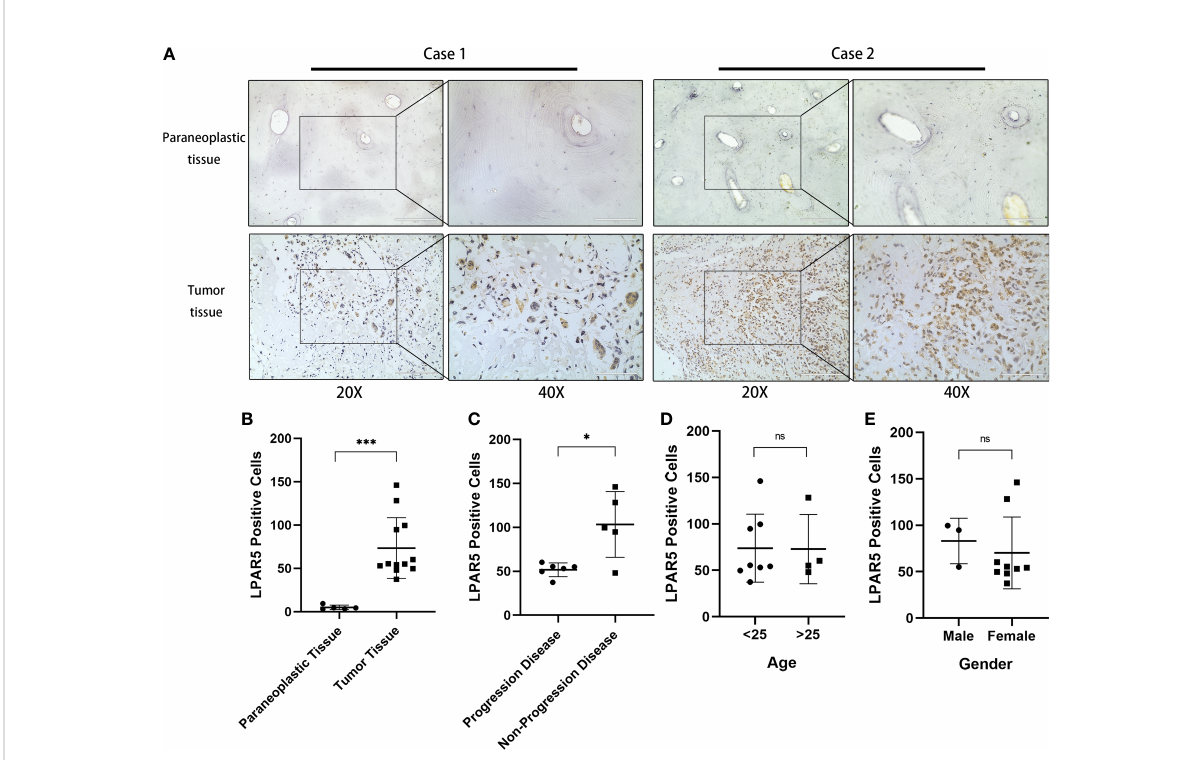
FIGURE 11 Immunohistochemical staining. (A) Immunohistochemical staining of LPAR5 in osteosarcoma sample and normal sample. Scale bar (20× = 200 m m, 40× = 100 m m). (B) The difference of LPAR5 expression in tumor and paraneoplastic tissues. (C) The difference of LPAR5 expression in progression disease patient and no progression disease patients. (D) LPAR5 expression in patients under 25 years of age and patients over 25 years of age. (E) LPAR5 expression between male and female. *: P<0.05; ***: P<0.001; ns, not signi fi cant.